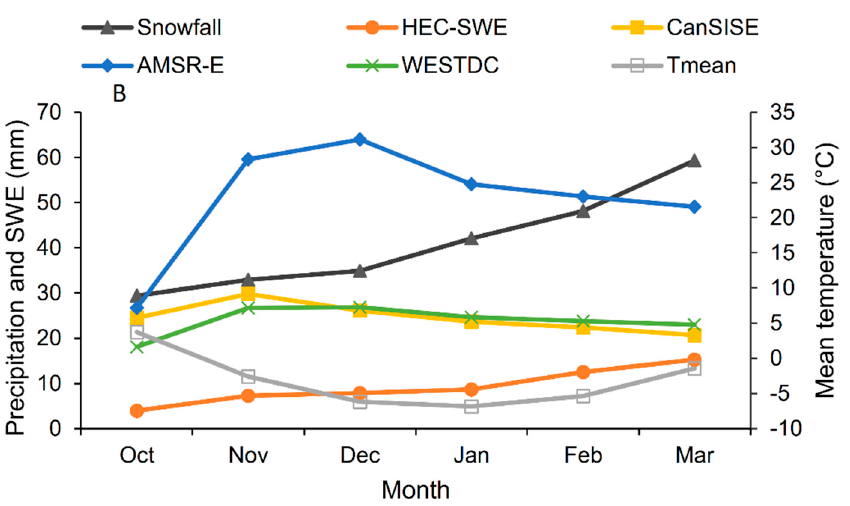
Figure 12. Comparison of remote sensing SWE and HEC-SWE with accumulated snowfall for the period 2001–2010, during the snowfall period (October–March) in the SLR.